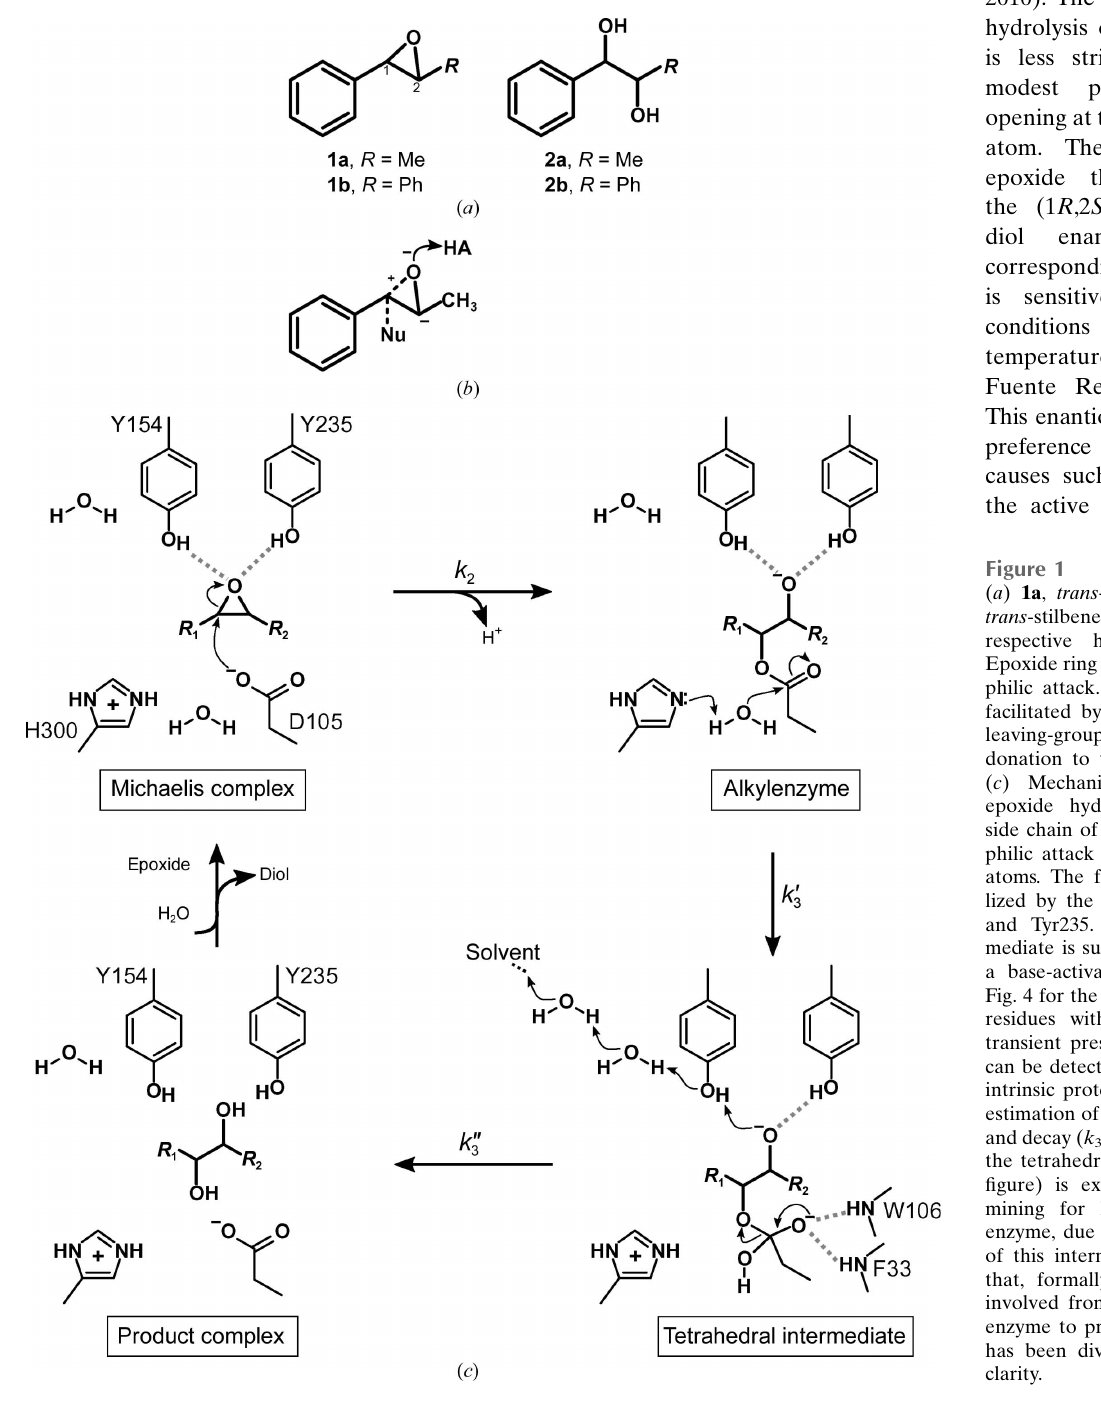
Figure 1 ( a ) 1a , trans -methylstyrene oxide; 1b , trans -stilbene oxide. 2a and 2b are the respective hydrolysis products. ( b )